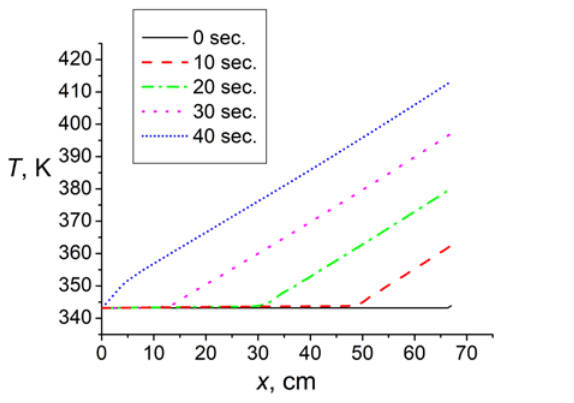
Fig. 2. Temperature in the heat pipe at different time moments.